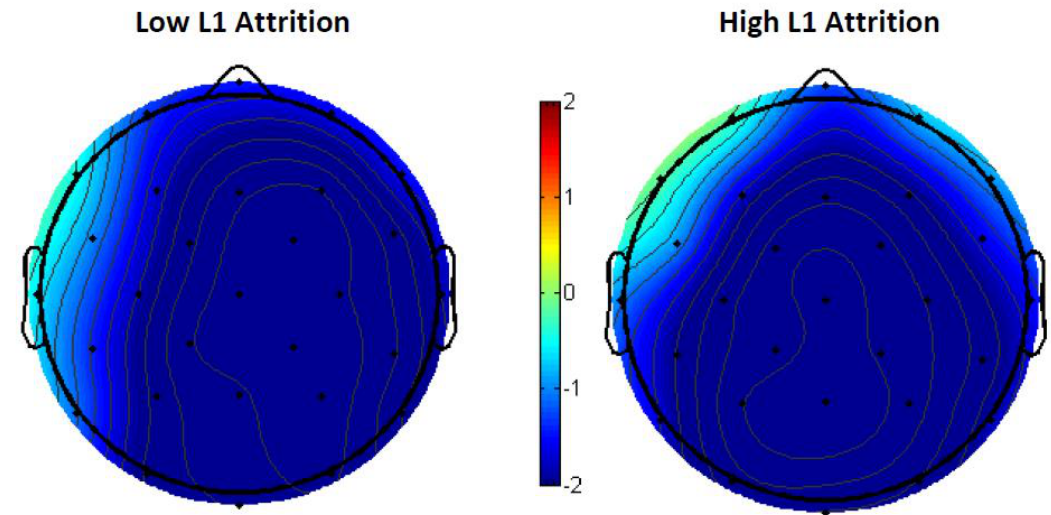
Figure 8. The 300 – 500-ms voltage maps of semantic priming effect (semantically unrelated – semantically related) between low and high L1 attrition bilinguals, with blue indicating a net negative effect.